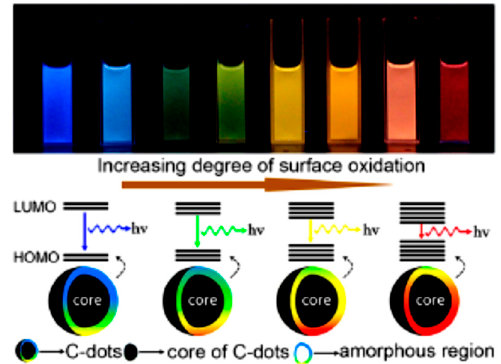
Figure 6. Photoluminescence (PL) of CDs as a function of surface oxidation. Reproduced from [28] with permission of American Chemical Society, copyright 2016.